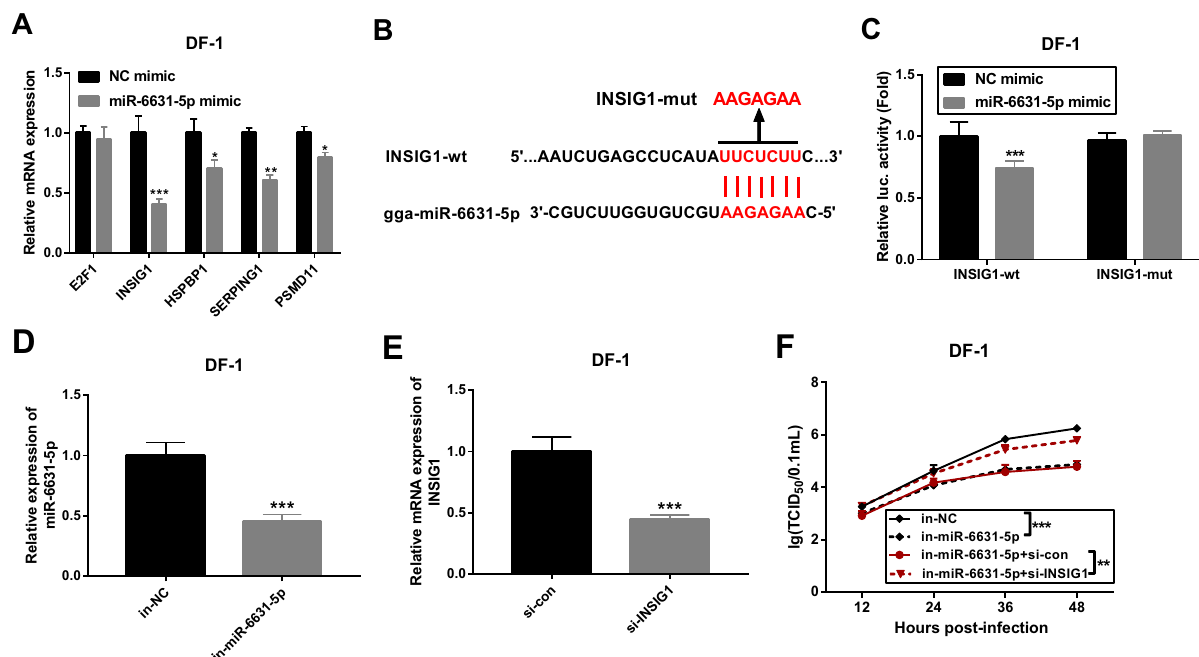
Figure 7. The introduction of gga-miR-6631-5p inhibitor hindered LaSota NDV replication by up-regulating INSIG1 in DF-1 cells. ( A ) The effect of gga-miR-6631-5p overexpression on E2F1, INSIG1, HSPBP1, SERPING1 and PSMD11 mRNA expression was tested by RT-qPCR assay in DF-1 cells at 48 h after transfection. ( B ) Putative complementary sites between gga-miR-6631-5p and INSIG1 3’UTR, and mutant sites in INSIG1- mut reporter. ( C ) DF-1 cells were co-transfected with NC mimic or gga-miR-6631-5p mimic and INSIG1-wt reporter or INSIG1-mut reporter, followed by the detection of luciferase activities at 48 h after transfection. ( D ) The level of gga-miR-6631-5p was measured by RT-qPCR assay at 48 h post transfection in DF-1 cells transfected with in-miR-6631-5p or in-NC. ( E ) DF-1 cells were transfected with si-con or si-INSIG1. Forty-eight hours later, INSIG1 mRNA level was measured through RT-qPCR assay. ( F ) DF-1 cells were transfected with in-NC (100 nM), in-miR-6631-5p (100 nM), in-miR-6631-5p (100 nM) + si-con (100 nM), or in-miR-6631-5p (100 nM) + si-INSIG1 (100 nM). Non-transfected cells acted as the control group. At 24 h after transfection, cells were infected with LaSota NDV at the MOI of 1. Next, TCID 50 assay was performed at the indicated time points (12, 24, 36, 48 h) after LaSota